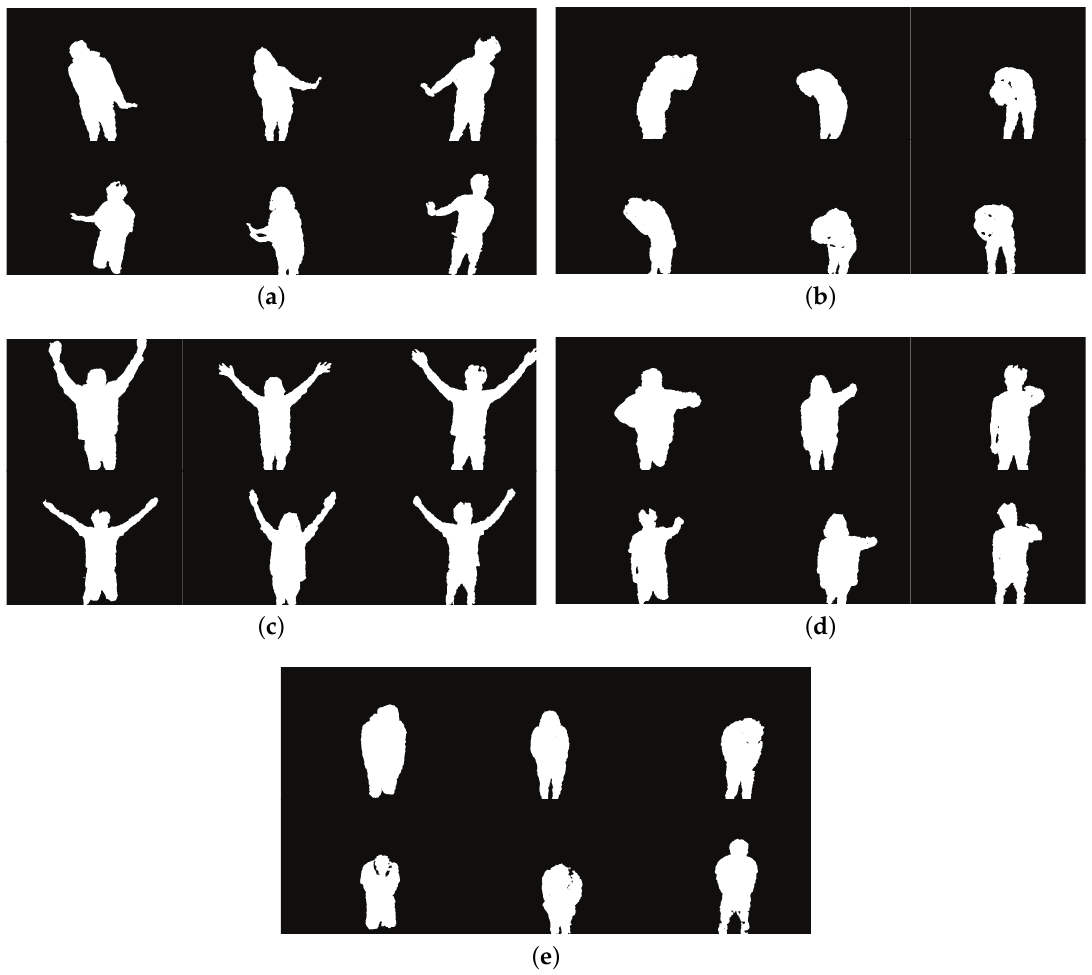
Figure 3. Visual results of all of the emotions in terms of binary image. ( a ) Disgust; ( b ) Fearfulness; ( c ) Happiness; ( d ) Hot anger; ( e )